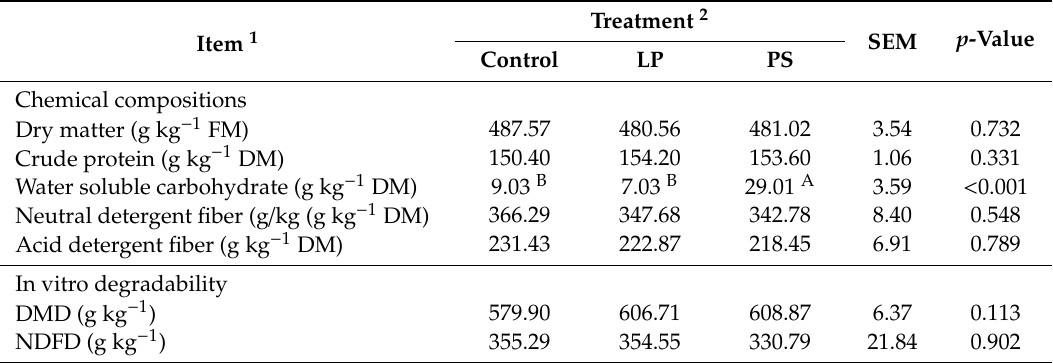
Figure 1. Gas production profiles from in vitro fermentation of the TMR silage for 48 h (bars indicate standard errors of the means). LP, Lactobacillus plantarum inoculant; PS, potassium sorbate. Table 4. Chemical compositions and in vitro digestibility of the total mixed ration silages after 30 days of